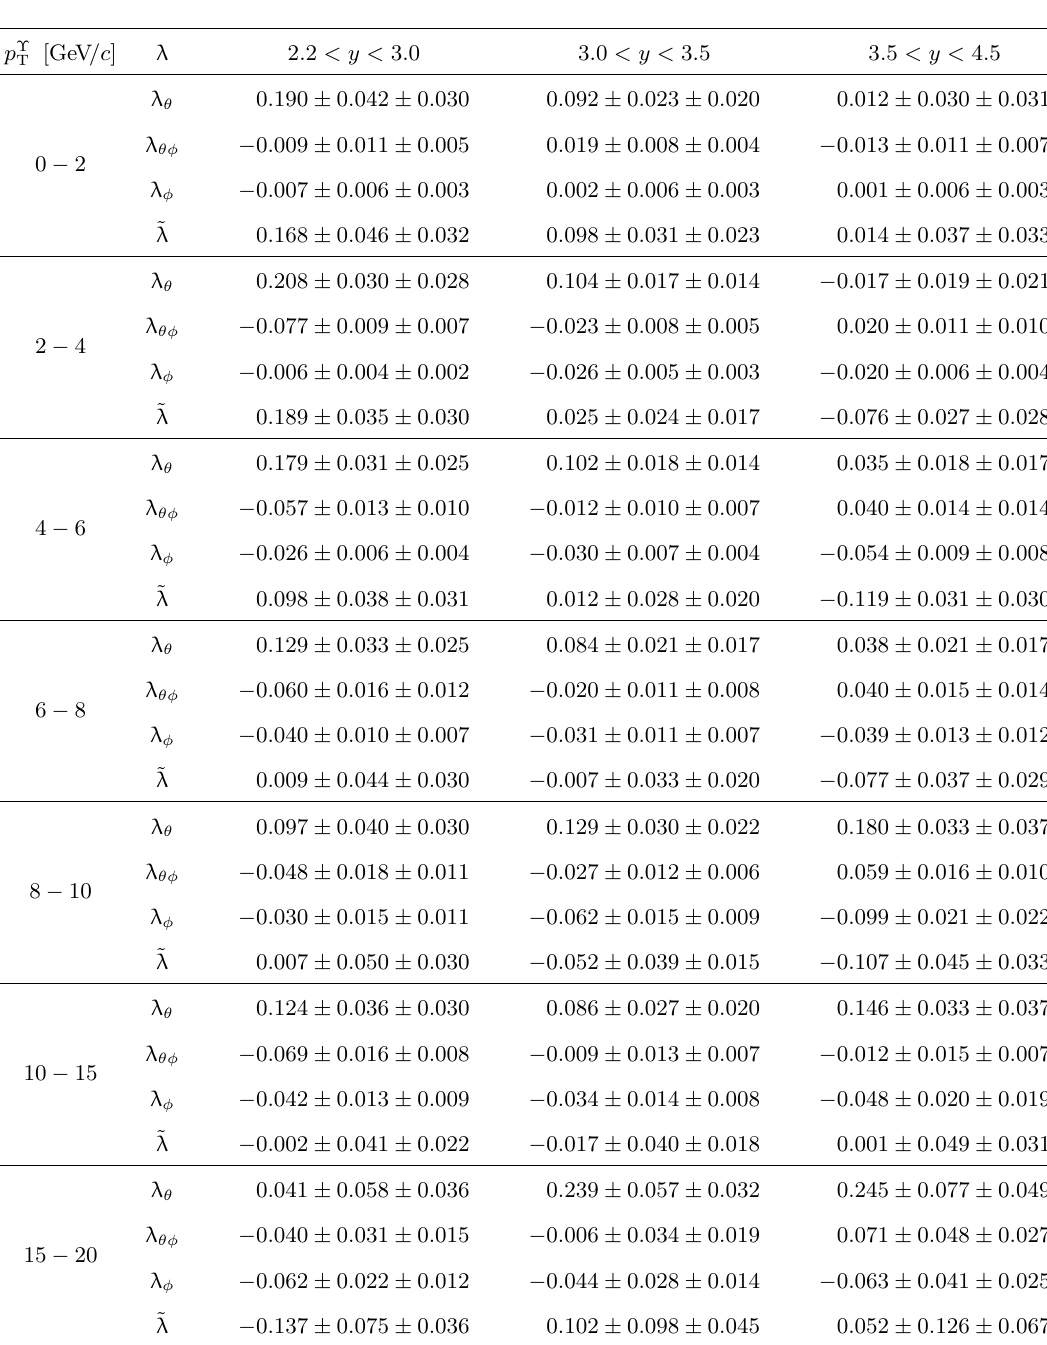
Table 3 . Values of (cid:21) (cid:18) , (cid:21) (cid:18)(cid:30) , (cid:21) (cid:30) and ~ (cid:21) measured in the HX frame for the (cid:7)(1S) produced at p s = 8 TeV. The (cid:12)rst uncertainty is statistical and the second systematic.